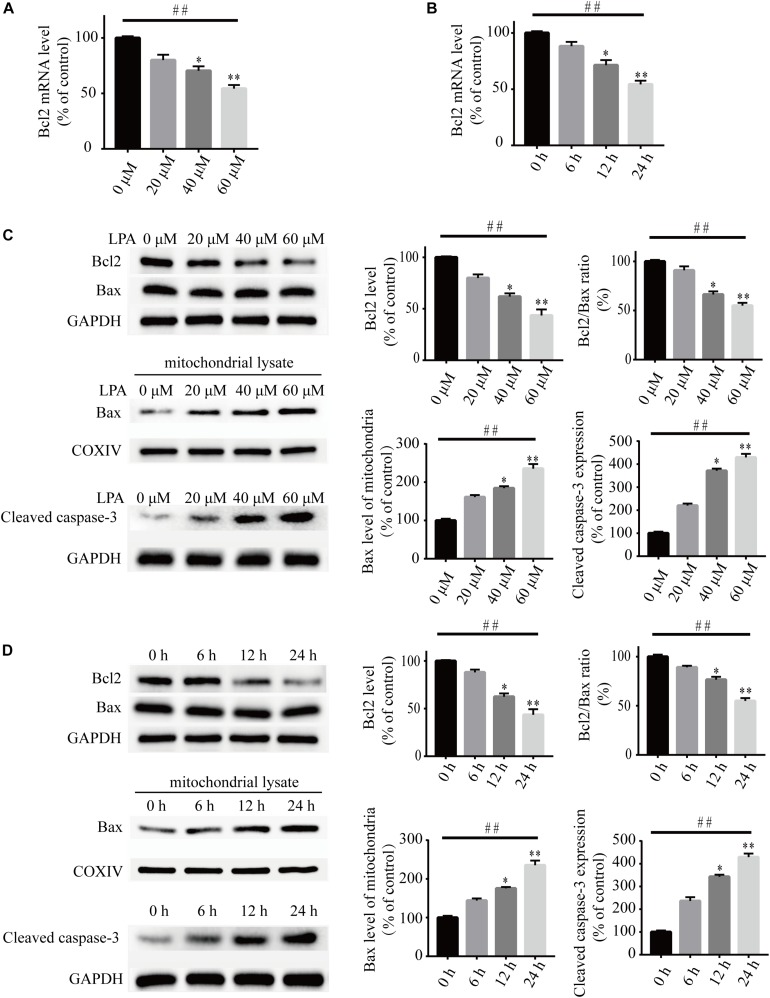
Lysophosphatidic acid decreases the Bcl2 mRNA level, Bcl2 protein level, and Bcl2/Bax ratio while it increases the translocation of Bax and the activation of caspase-3 in neuronal PC12 cells. Q-PCR measures the Bcl2 mRNA level in neuronal PC12 cells treated with LPA (A,B). Western blot detects the protein levels of Bcl2, Bax and cleaved caspase-3 in whole cells as well as the Bax protein level in mitochondria of neuronal PC12 cells (C,D). Data are mean ± SEM of five independent experiments for Kruskal–Wallis test, ##P < 0.01; for Bonferroni post hoc test (compare each group with control), ∗P < 0.05, ∗∗P < 0.01.